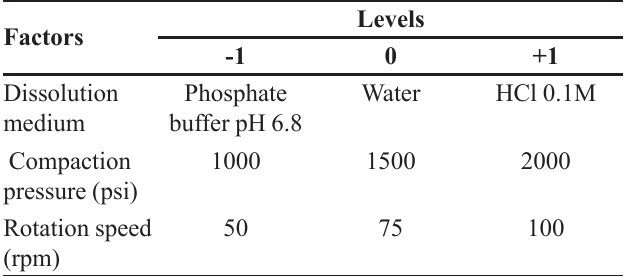
TABLE I - Independent variables (factors) and levels used in the experimental design for intrinsic dissolution tests of amlodipine